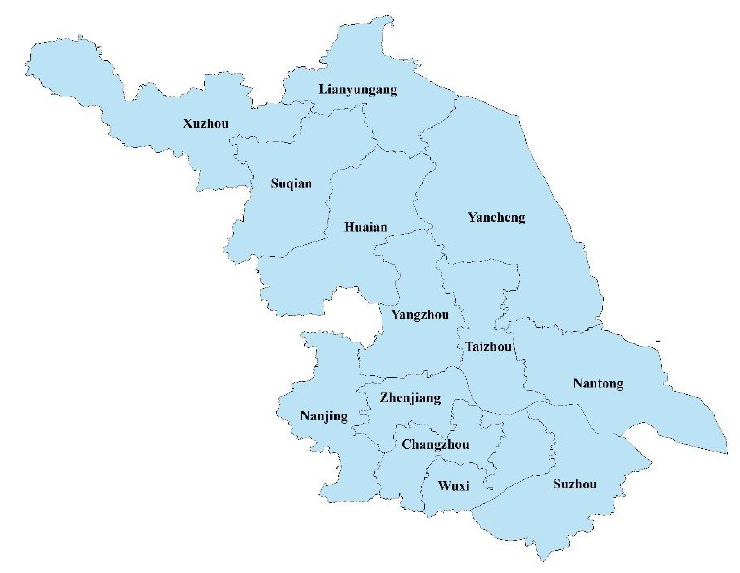
Figure 2. Map of Jiangsu Province.